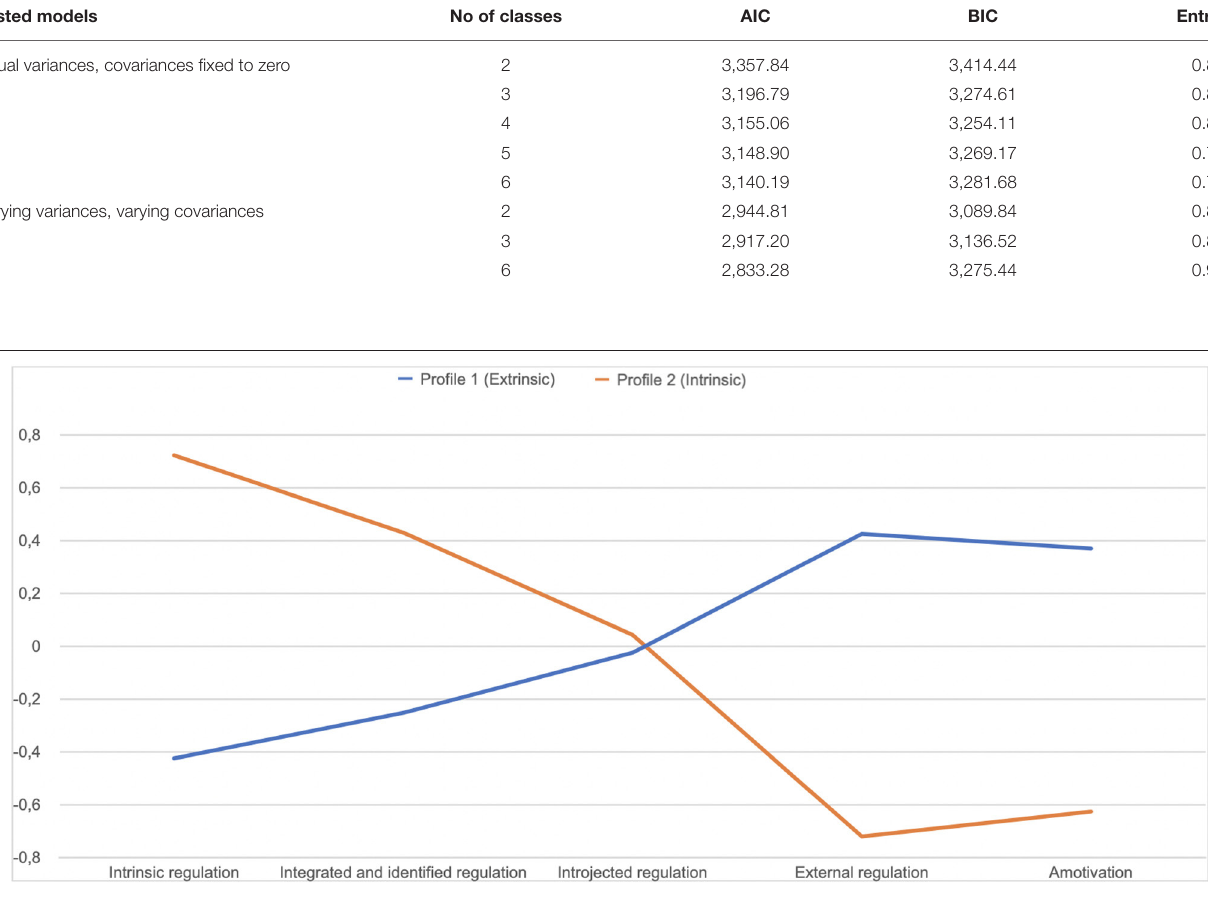
TABLE 8 | Fit indices and entropy values for models tested in latent profile analysis, Study 2.